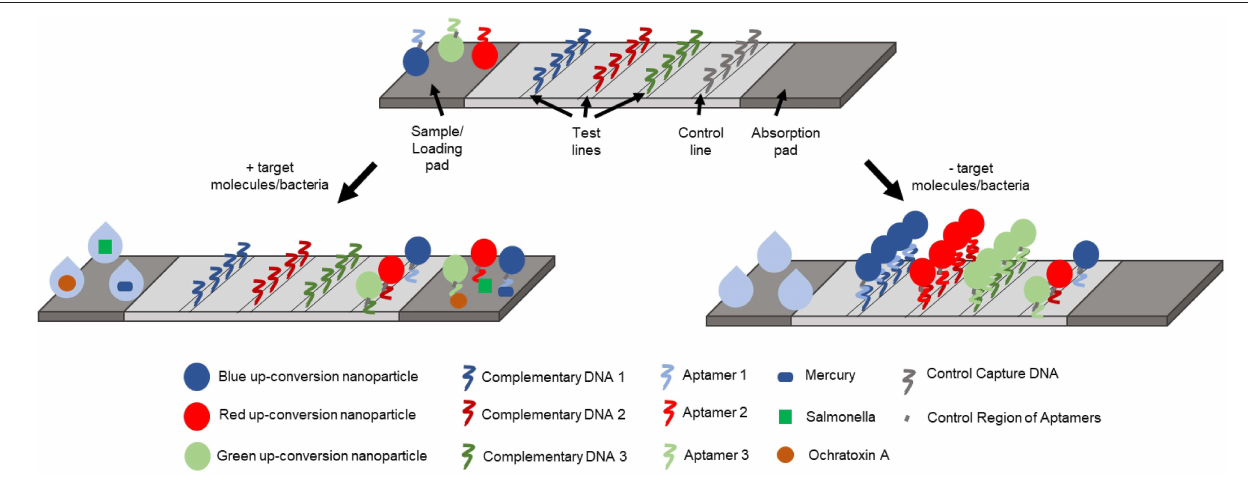
FIGURE 7 | Schematic representation of the lateral-flow aptamer assay developed for the detection of multiple analytes in environmental water samples (Jin et al., 2018